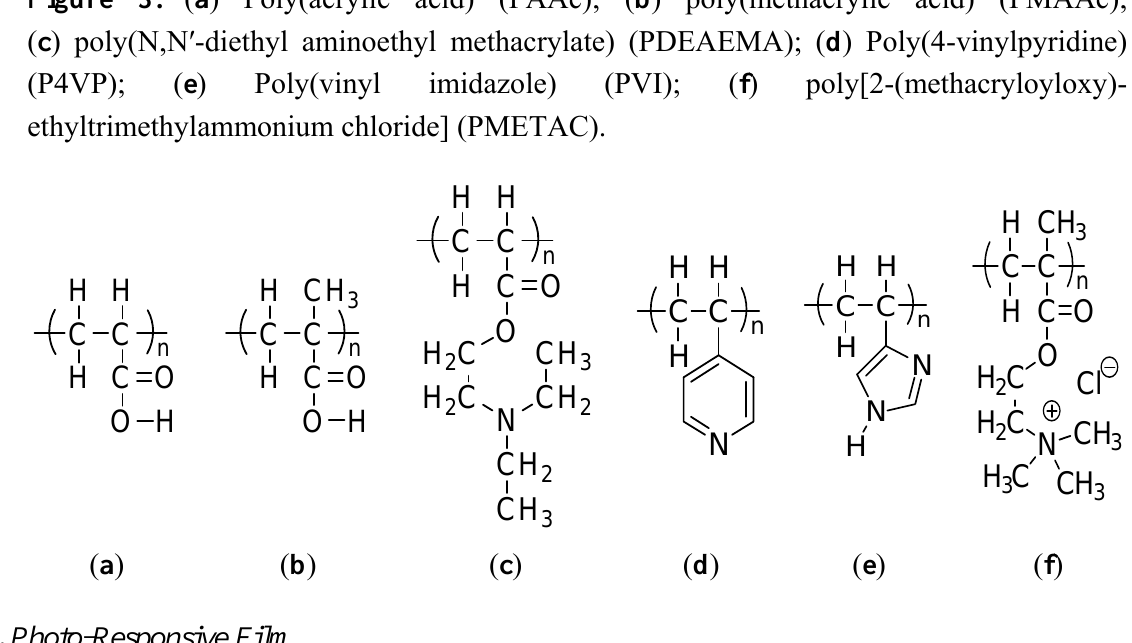
3. ( a ) Poly(acrylic acid) (PAAc); ( b ) poly(methacrylic acid) (PMAAc); ( c ) poly(N,N ′ -diethyl aminoethyl methacrylate) (PDEAEMA); ( d )